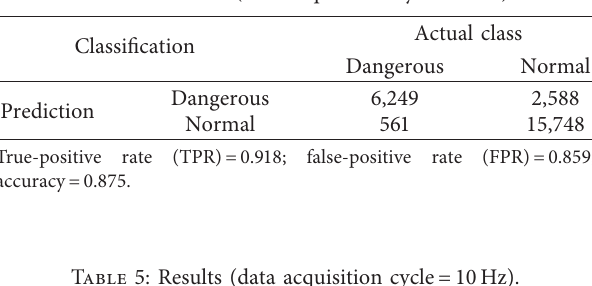
Table 5: Results (data acquisition cycle � 10Hz). Classification